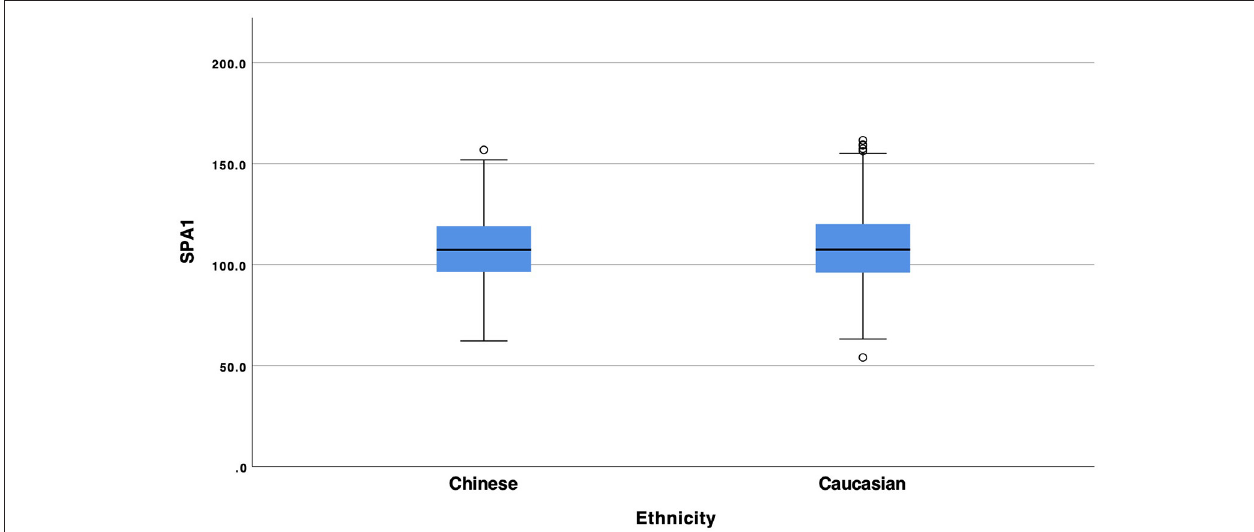
FIGURE 1 | Box and whiskers plot of SP-A1 of Chinese and Caucasian population.